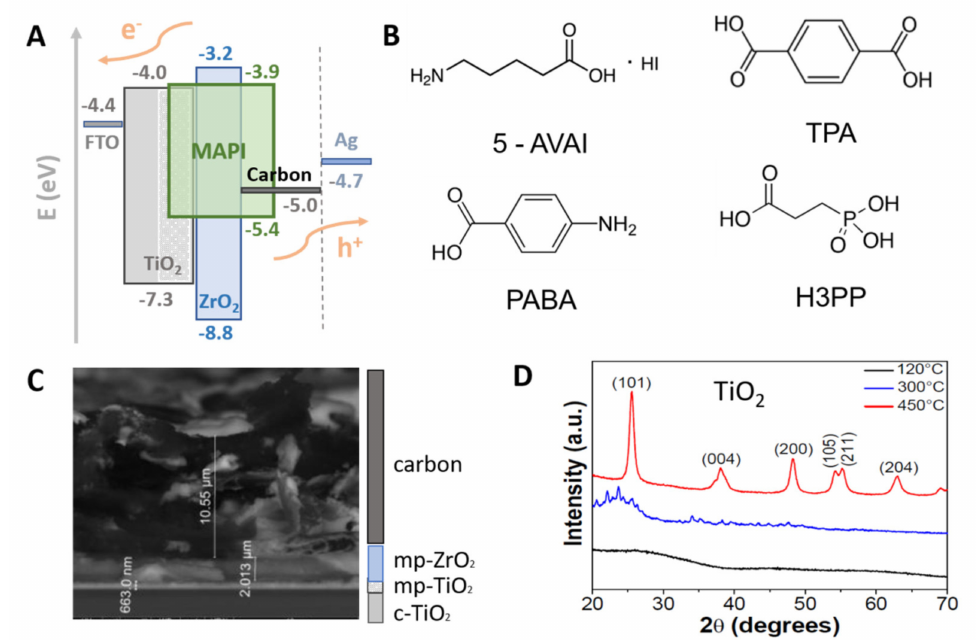
Figure 1. ( A ) Schematic structure of band gaps and work function of the different layers of the solar cells; ( B ) Molecular structure of the four additives used in the methyl-amino lead-iodide (MAPI) layer: 5-amino-valeric acid iodide (5–AVAI), terephthalic acid (TPA), para-4-aminobenzoic acid (PABA) and 3-phosphono-propionic acid (H3PP); ( C ) SEM image of the shell used to infiltrate the MAPI, showing the layers of compact and mesoporous TiO 2 , mesoporous ZrO 2 and carbon; ( D ) XRD of anatase TiO 2 at different